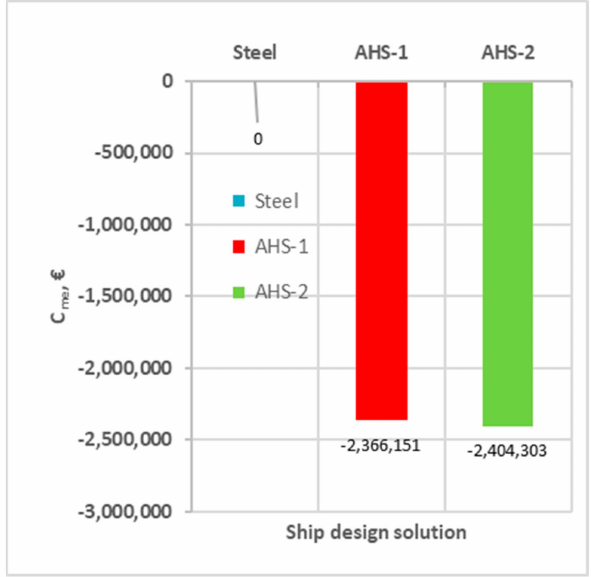
Figure 8. Cost of structural